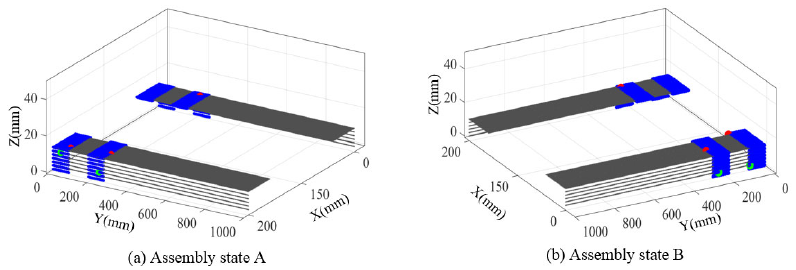
Figure 13. Determined contact points of assembly state A and B. Table 5. Acquired position and orientation deviations (PODs) of the rectangular sliding guide.